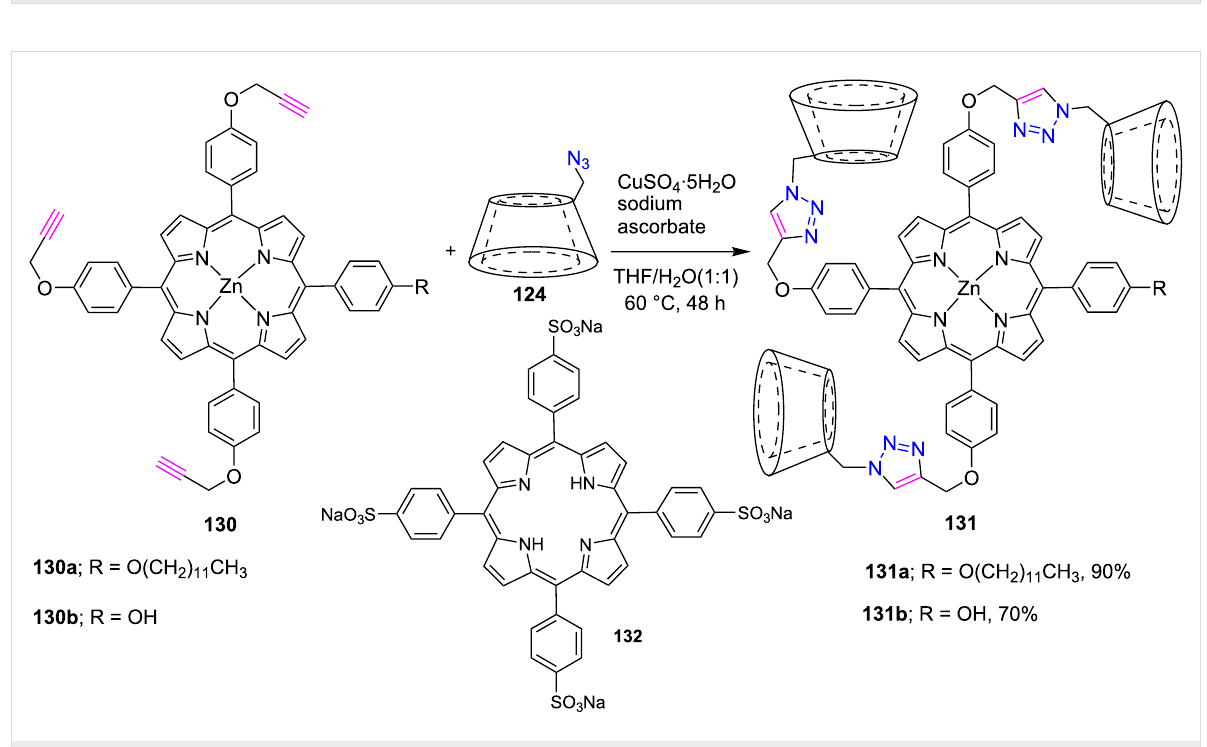
Scheme 26: Synthesis of 1,2,3-triazole-linked porphyrin- β -CD conjugates 131a , b